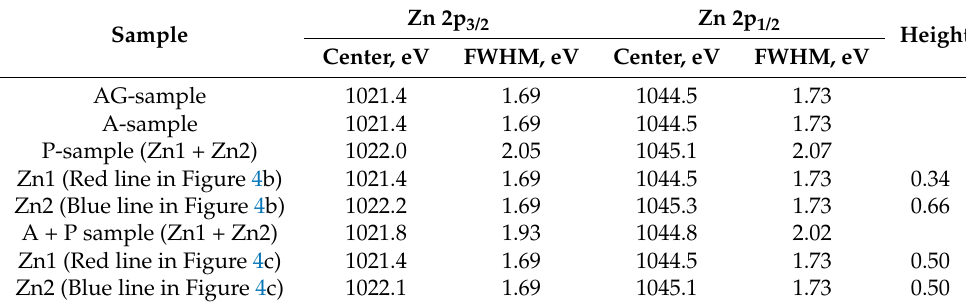
Table 1. Parameters of XPS Zn2p spectra of the samples.